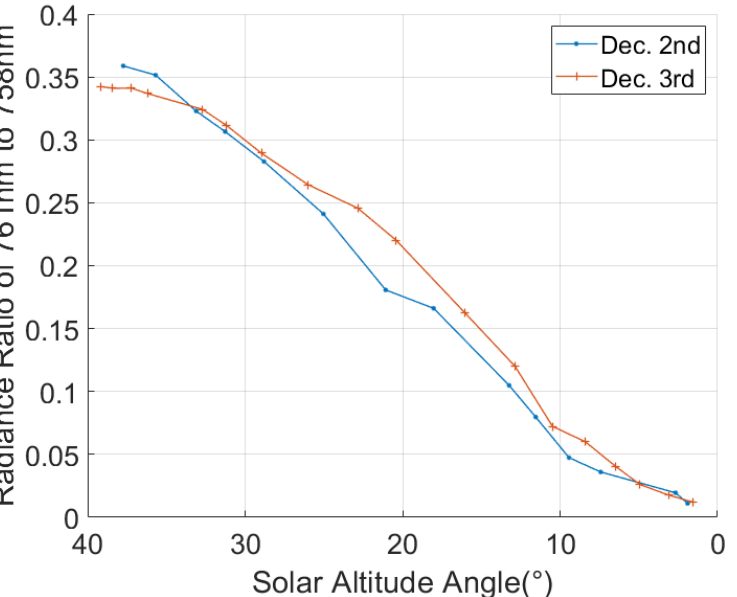
Figure 18. Radiance data for the different solar altitude angles that are obtained from consecutive observations on the afternoon of December 2nd and 3rd.